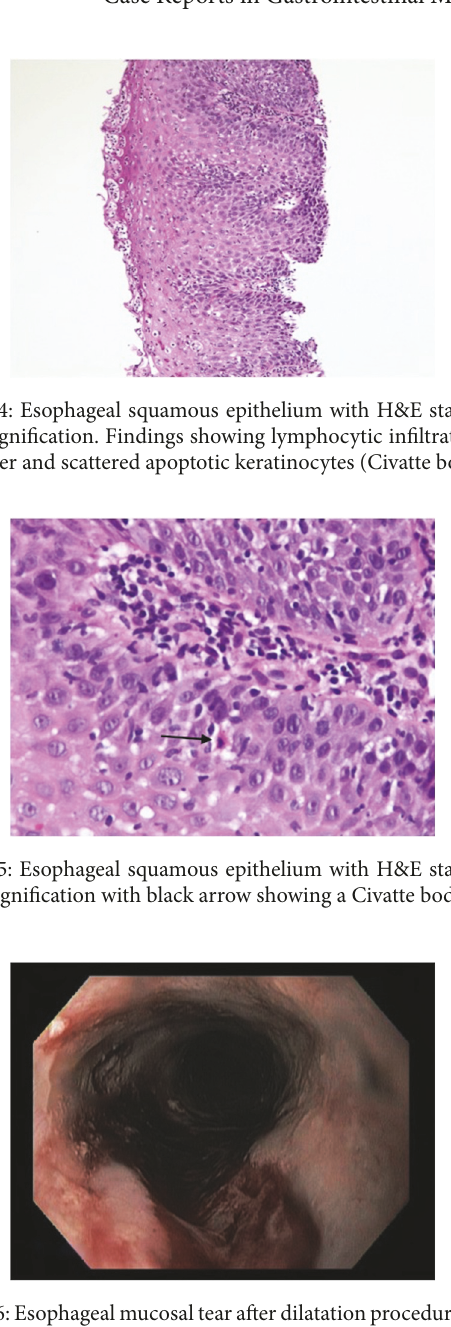
Figure 6: Esophageal mucosal tear after dilatation procedure occur- ring late in the patient’s course highlighting the potential increased risk of complications with further endoscopic